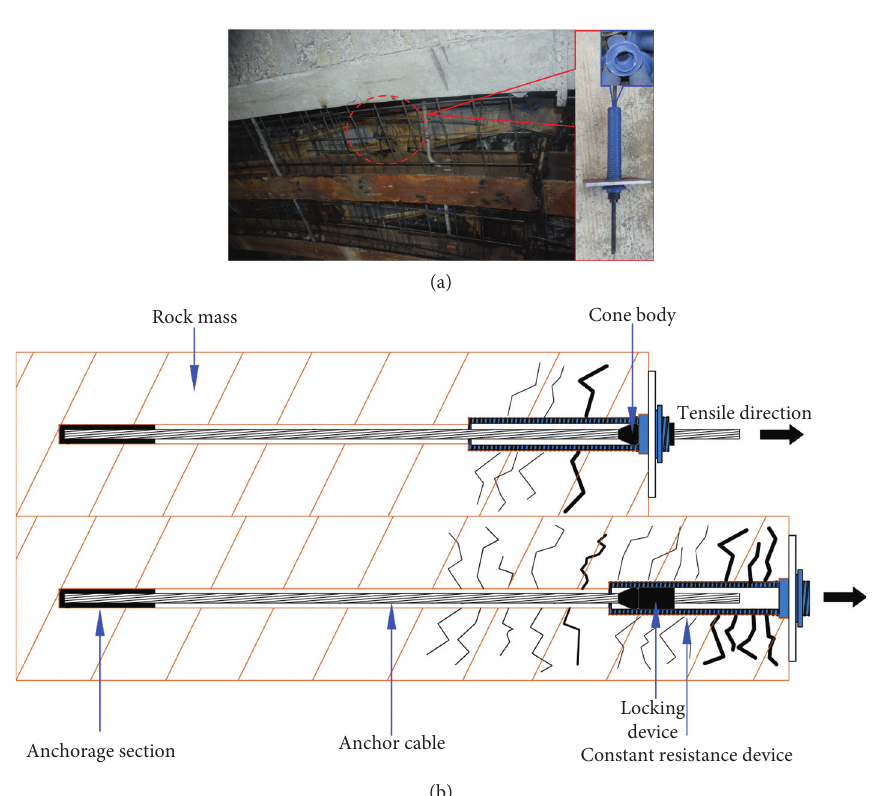
Figure 17: Constant resistance and large deformation anchor cable. (a) Photos of constant resistance anchor cable support. (b) Working principle of constant resistance anchor